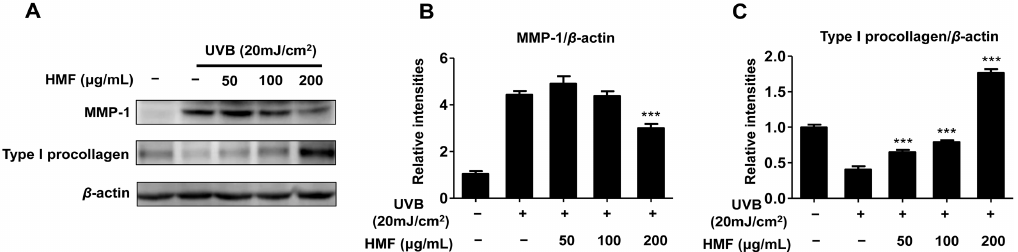
Figure 3. Effects of 3,5,6,7,8,3 ′ ,4 ′ -heptamethoxyflavone (HMF) on cellular matrix metalloproteinases 1 (MMP-1) protein and type I procollagen protein expression in HDFn cells. HDFn cells were pretreated with HMF (50, 100, and 200 µ g/mL) for 24 h following treatment with UVB irradiation (20 mJ/cm 2